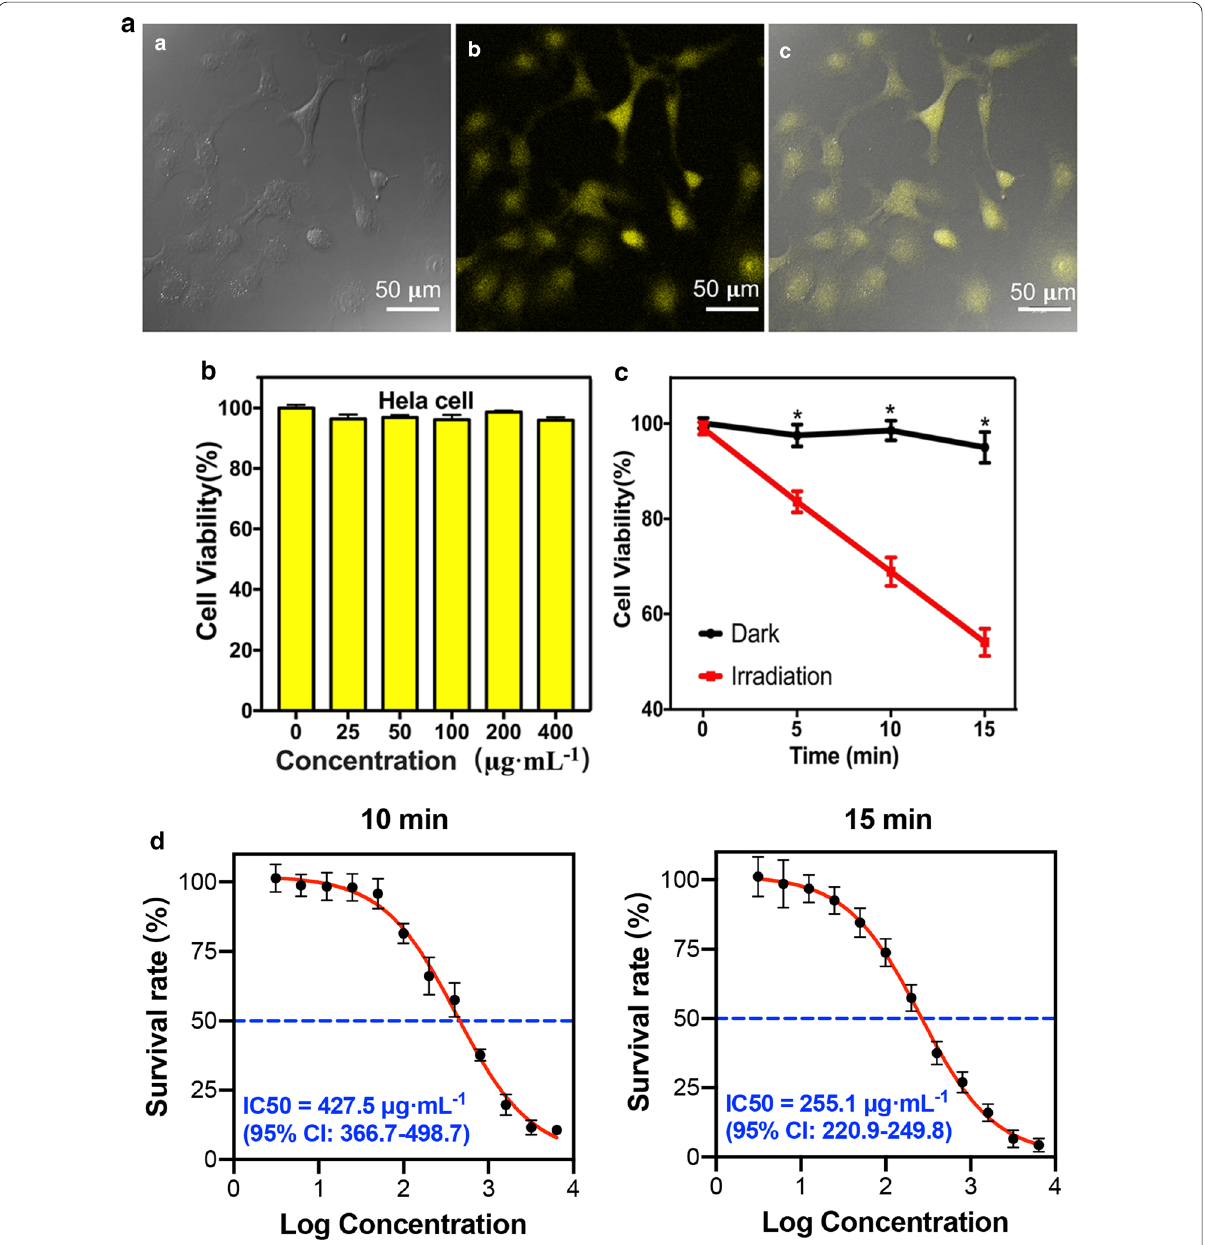
Fig. 3 Application of CQDs. A CLSM imaging of HeLa cells labeled with CQDs; B In vitro cytotoxicity test of CQDs; C Relative viability of HeLa cells incubated with control solution or CQDs (200 μg mL − 1 ) and exposed to blue light (460 nm, 30 mW cm − 2 ) for 5 min, 10 min, and 15 min; D The IC50 of excited CQDs on Hela cells after exposure to blue light for 10 and 15 min (* P <